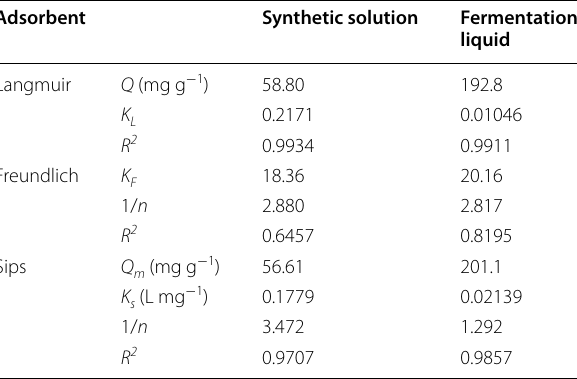
Table 3 Parameters of adsorption isotherm models Adsorbent Synthetic